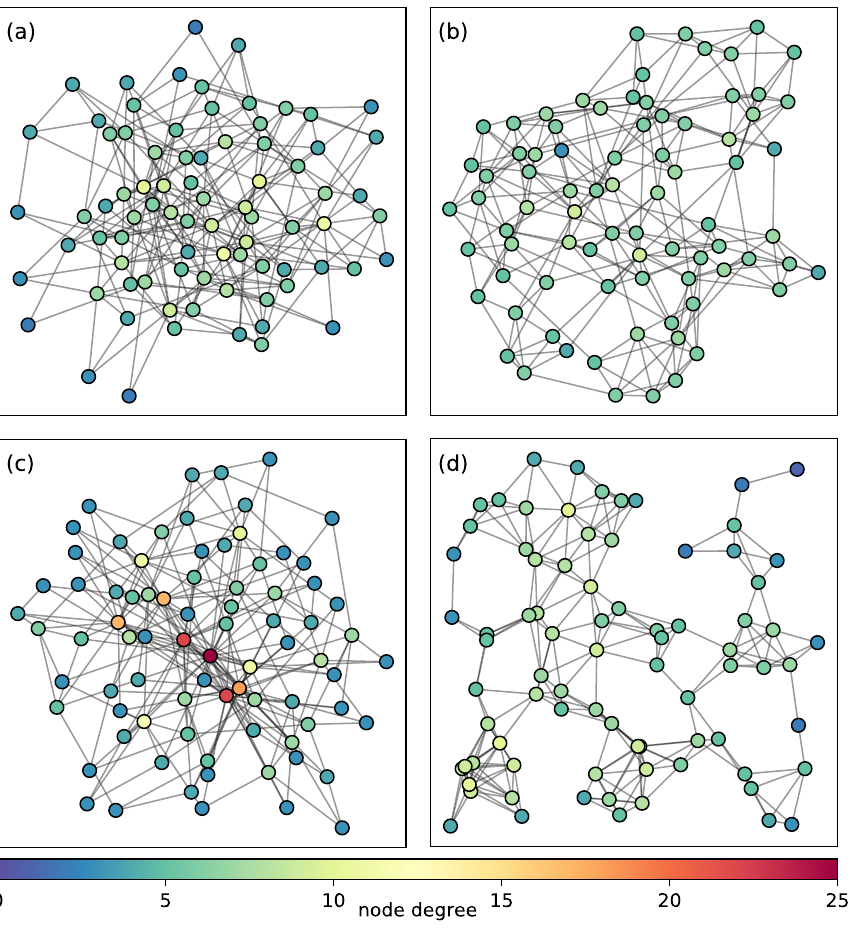
Figure 4. Examples of graphs for the four considered graph families: ( a ) Erdős-Rényi ( b ) Watts–Strogatz small world ( c ) Barabasi–Alber scale-free ( d ) geometric random graphs. All graphs have network size n 6 . Nodes are coloured based on their average degree deg avg ≈